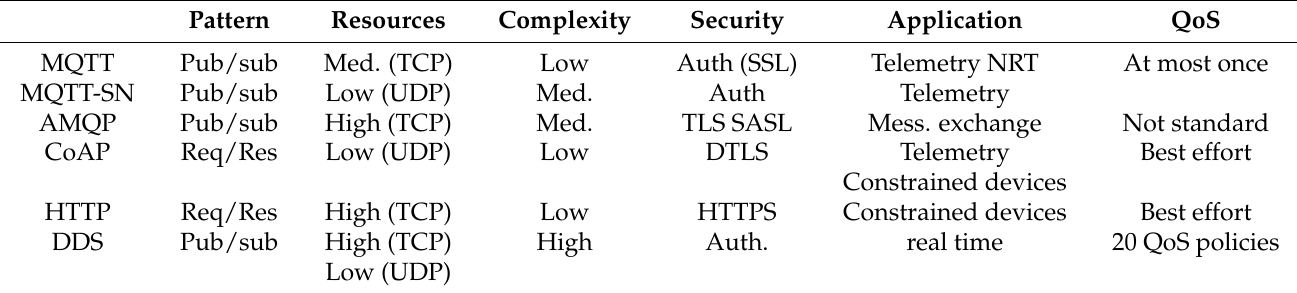
Figure 9. L1 industrial wireline technologies. SP2-Aeronautics, SP3 Automotive, SP4 Railway, SP5 Building. Table 4. Comparison L1 middleware